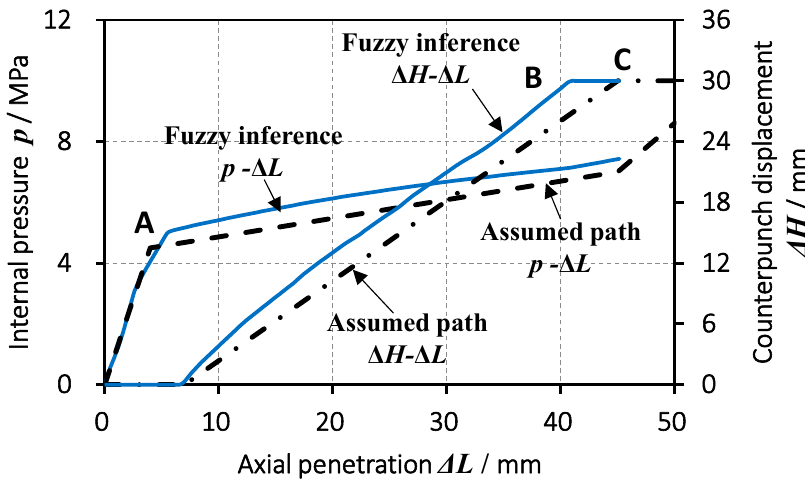
Figure 13. Comparison of loading path between the manual set from experience and the fuzzy inference model (250 °C), p: internal pressure, ∆ H : counterpunch displacement, ∆ L : axial penetra- tion.